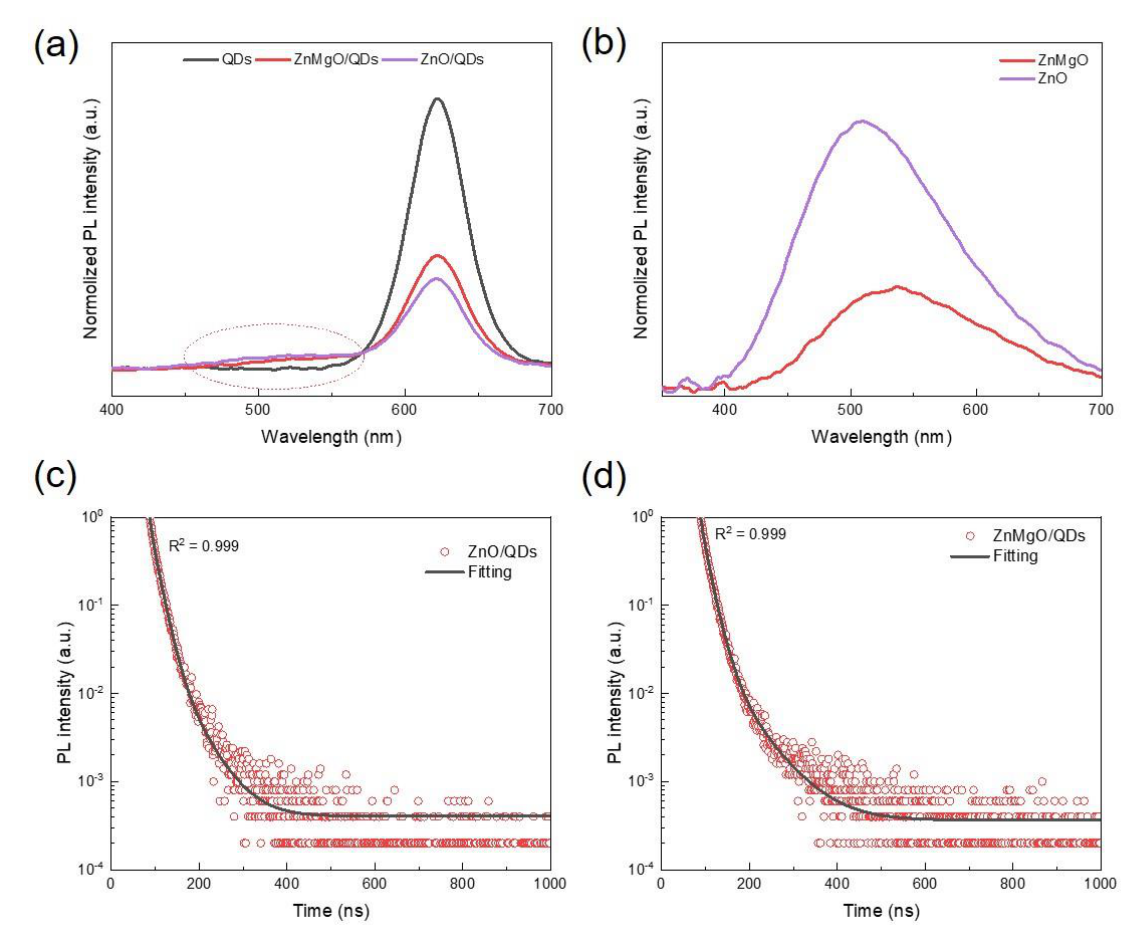
Figure 3. ( a ) PL intensity of QDs, ZnMgO/QDs, and ZnO/QDs films; ( b ) PL intensity of ZnMgO and ZnO films; ( c ) TRPL spectra of the QDs using ZnO ETL; and ( d ) TRPL spectra of the QDs using ZnMgO ETL. The solid lines are the fitting curves through a three-exponential decay model.